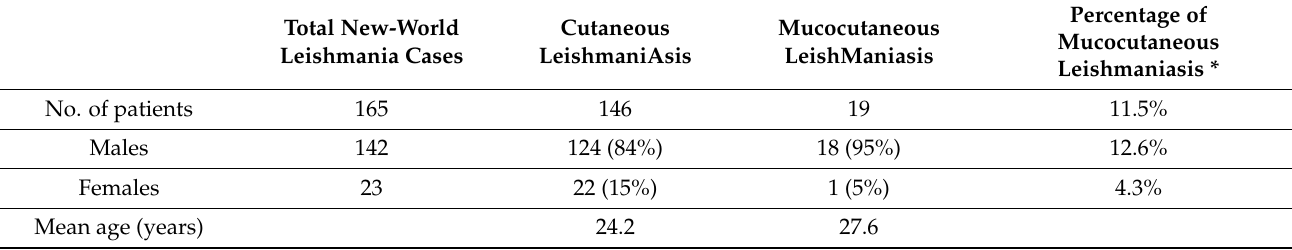
Table 2. Comparison between New-World CL patients and MCL patients with cutaneous leishmania- sis and mucocutaneous